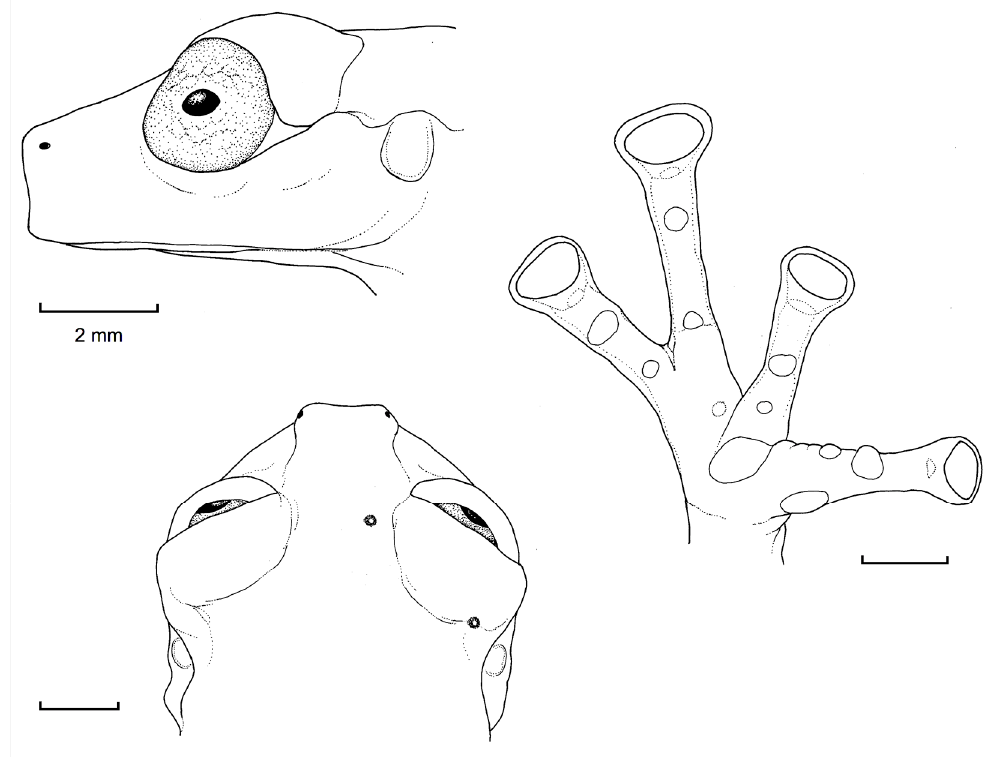
Figure 141. Nymphargus cochranae . ( A ) Head in lateral and ventral views, adult female, QCAZ 22197. ( B ) Hand in ventral view, adult male, QCAZ 31113. Illustrations by Juan M. Guayasamin.